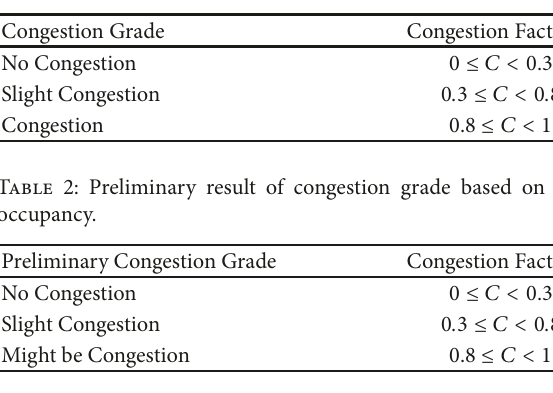
Table 1: Decide congestion factor based on vehicle density.